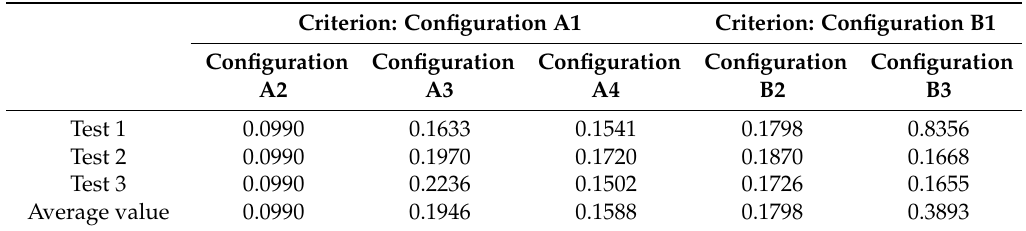
Table 10. The standard deviation of vehicle speed under different configurations (unit: m/s).